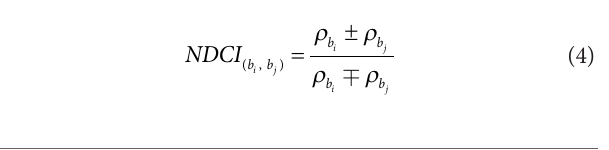
TABLE 3 | High-dimensional dataset generation based on optical and GF-3 SAR images. Sensors High dimensional